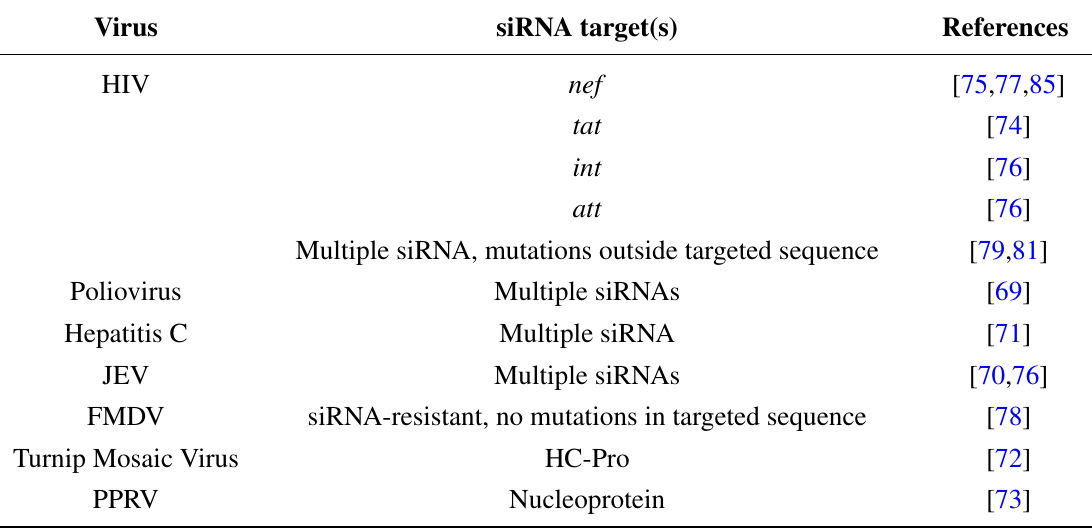
A selection of studies which document mutations in RNA viruses conferring resistance to